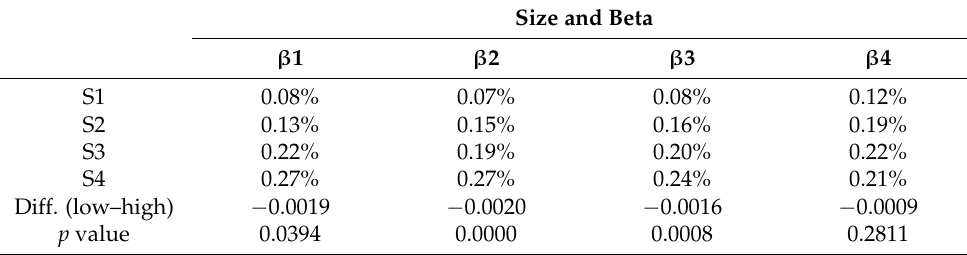
Table 1. Portfolio average returns based on size and beta. The table represents the average returns of 16 portfolios formed oversize and stock market beta. A total of 527 listed firms are analyzed, from which we dropped firms with negative book-to-market equity from the sample. Firms with missing values and no data were dropped. S1 to S4 represent small to large portfolio stocks, β 1 to β 4 represents low market beta to high market beta. Diff. (low–high) is the difference of small size with beta portfolios from large size with beta portfolios. p value is the significant value of two-sample t-test of average return difference of two said portfolios. It is tested at 1%, 5%, and 10% levels of